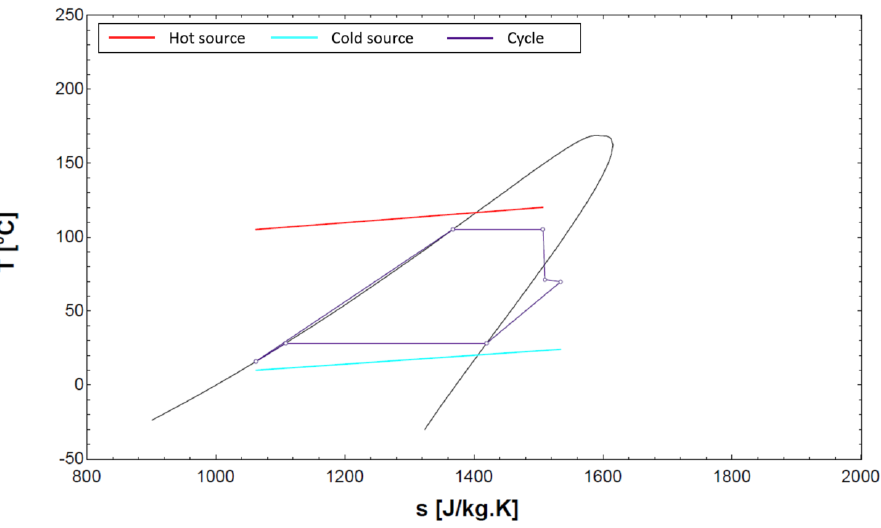
Figure 3. PEORC (Novec649 TM